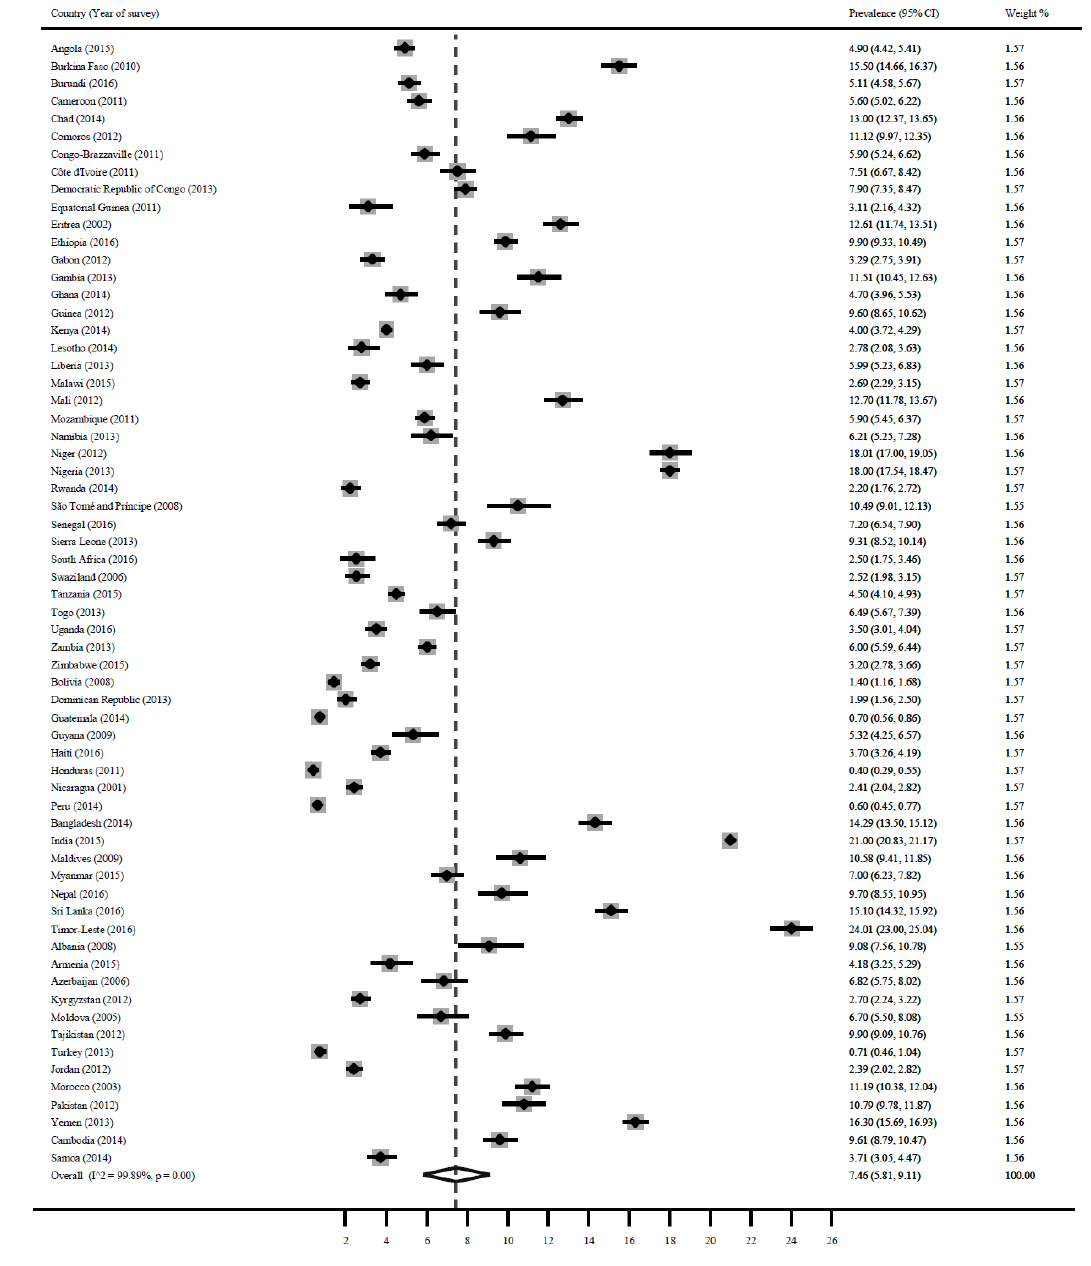
Figure 2. Prevalence of child wasting in LMICs.